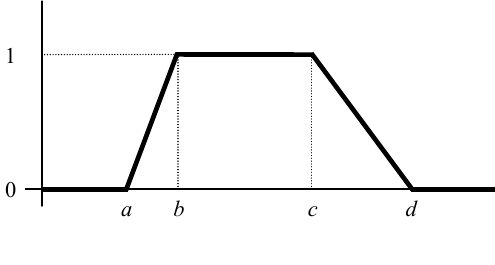
Fig. 1. Trapezoidal fuzzy